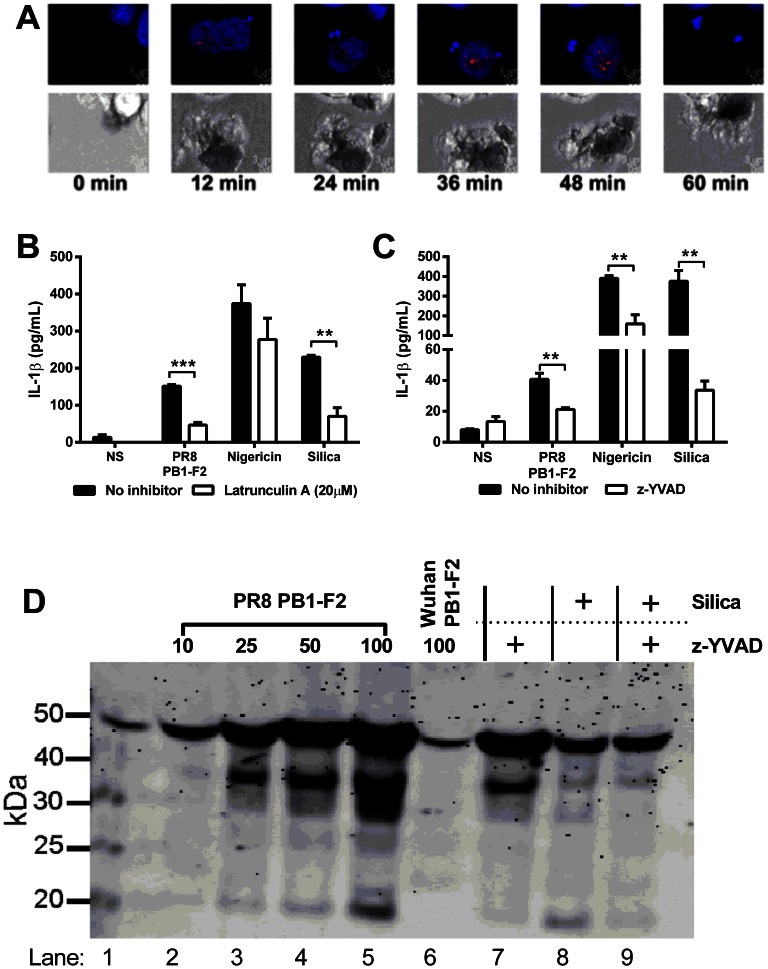
PR8 PB1-F2-mediated inflammation is NLRP3-, Caspase 1- and phagocytosis- dependent and induces ASC speck formation in macrophages.
A) Immortalized NLRP3-deficient macrophages stably reconstituted with ASC-cerulean (blue) and NLRP3 were seeded at 105/mL in 35 mm glass bottom dishes 24 h prior to stimulation with pHrodo-labeled (red) PB1-F2 peptide. Time-lapse imaging was performed for 3.5 h. Representative images shown are flattened maximum intensity projections of 3D deconvolved z-stacks using Imaris. Scale bar is 3 µm. See Video S1 and S2. Immortalized BMMs were primed with LPS, then B) pre-treated with 20 µM Latrunculin A (Lat A) for 45 min to inhibit phagocytosis, prior to stimulation with PR8 PB1-F2, nigericin (10 µM), silica (125 µg/mL), or unstimulated (NS) for 6 h; C) pre-treated with 10 µM caspase-1 inhibitor z-YVAD for 45 min, prior to stimulation with PR8 PB1-F2 (50 µg/mL), nigericin (10 µM), silica (125 µg/mL), or unstimulated (NS) for 6 h. Cellular supernatants were collected and analyzed for IL-1β secretion by ELISA according to manufacturer's instructions. Results are representative of three independent experiments and are represented as mean ± SEM. ** p<0.01 and *** p<0.001, Unpaired t-test. D) Immortalized wild-type macrophages were seeded at 2×106 cells in 6 well plates, 24 h prior to 3 h priming with LPS (200 ng/ml) in serum free media. Cells were pretreated (where indicated) with the caspase-1 inhibitor z-YVAD (20 µM) for 40 mins and then exposed to either PR8 or Wuhan PB1-F2 (50 µg/mL), or silica (125 µg/ml) for 6 h. Proteins were concentrated from cultured supernatants and separated by 4–12% SDS-PAGE, transferred to nitrocellulose and immunoblotted for caspase-1 cleavage. Result represents one of three independent experiments.